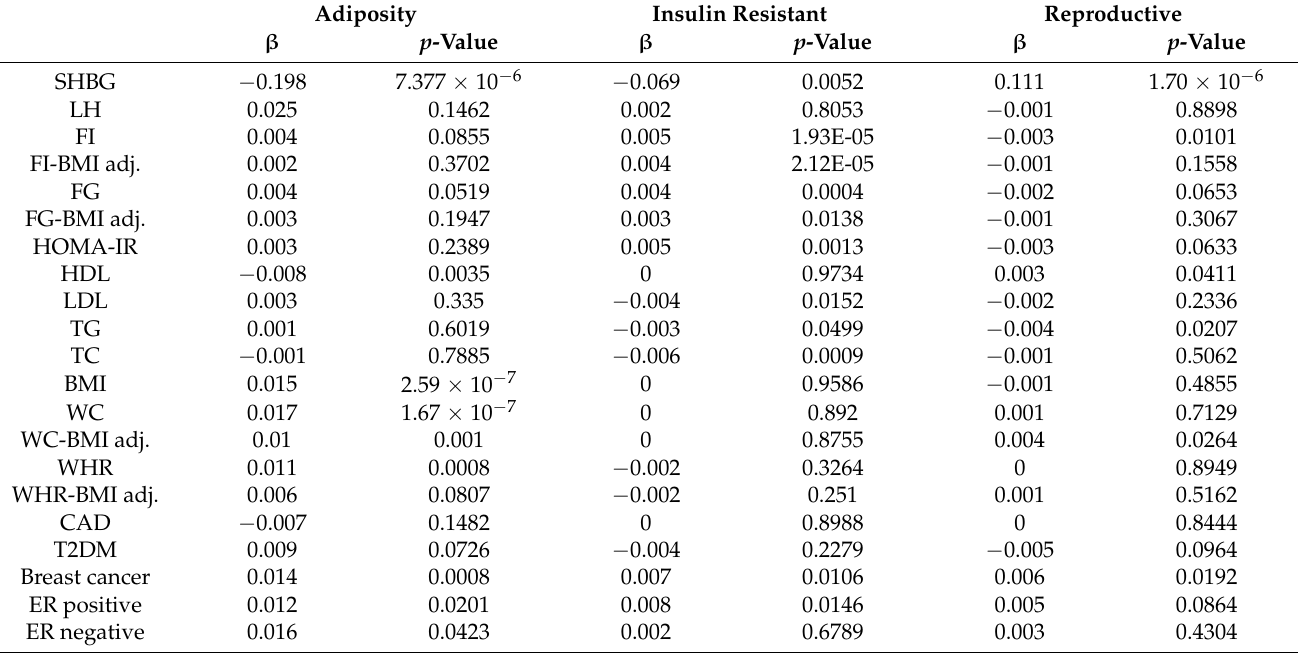
Table 1. The association of the genetic risk score of each cluster with traits and disease outcomes.